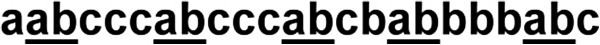
Example to generate each 2-gram “ab”.